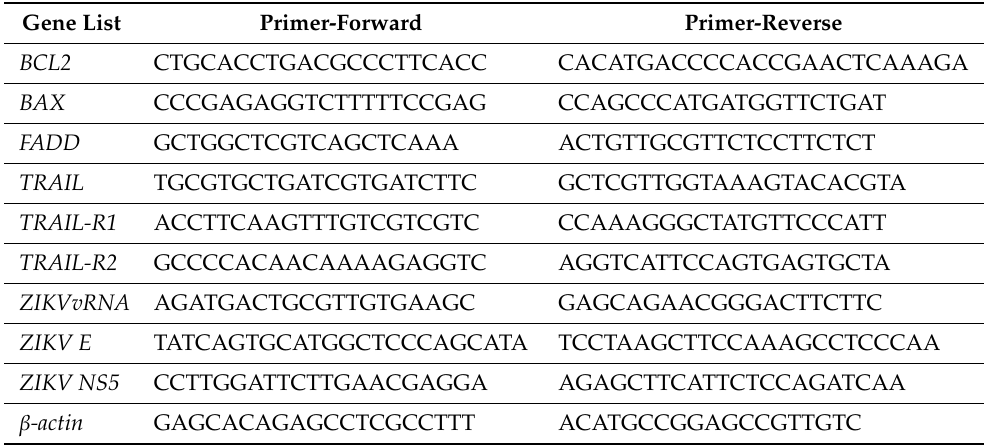
Table 1. Primer sequences used in this